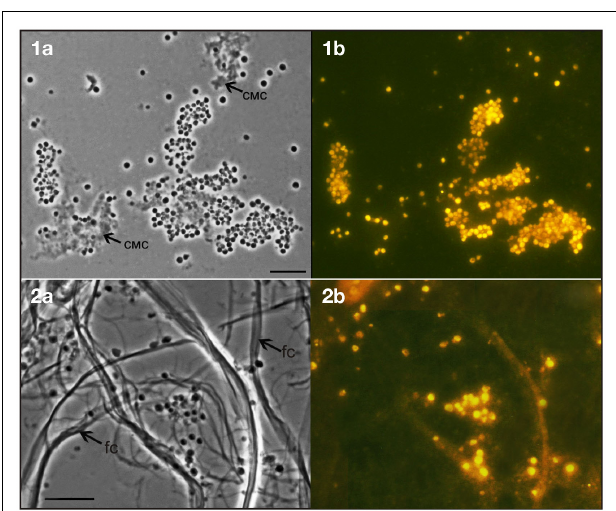
FIGURE 6 | Specific detection of cells of strain SP2 T grown on liquid medium M1 with carboxymethyl cellulose (CMC) (1) or fibrous cellulose (fc) (2) for 30days by FISH: phase-contrast image (A); epifluorescent micrographs of in situ hybridizations with Cy3-labeled probes PLA46 and PLA886 (B); bar, 5 μ m.